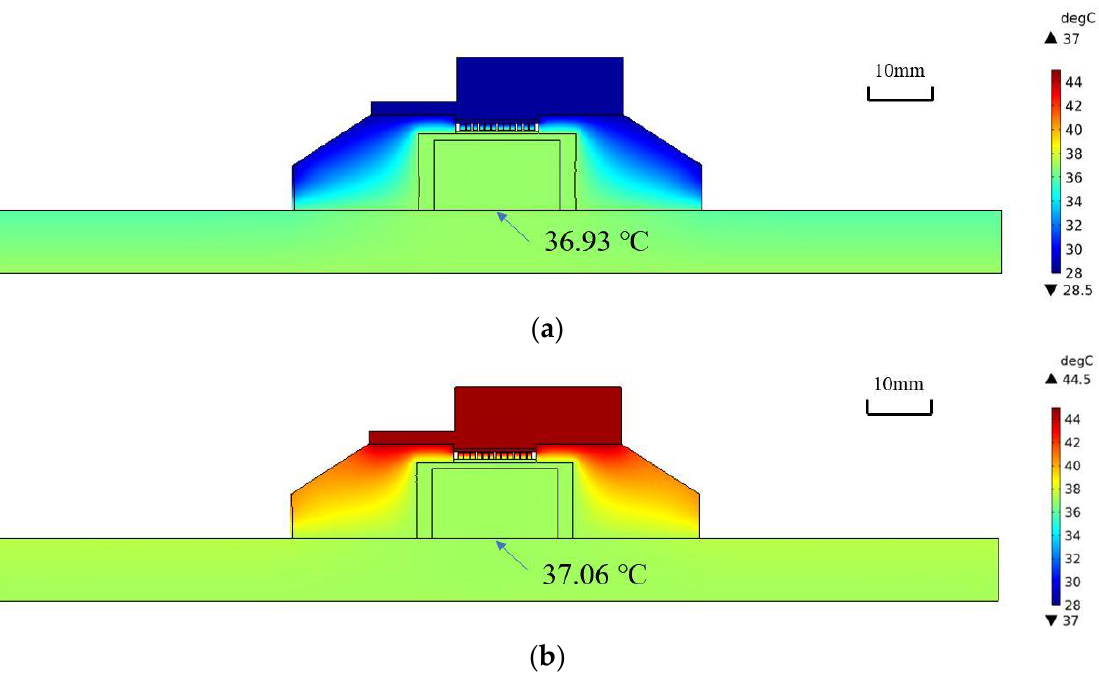
◦ C, t = 1970 s; ( b ) T ◦ C, t = 1970 Air = 25 Air = 42